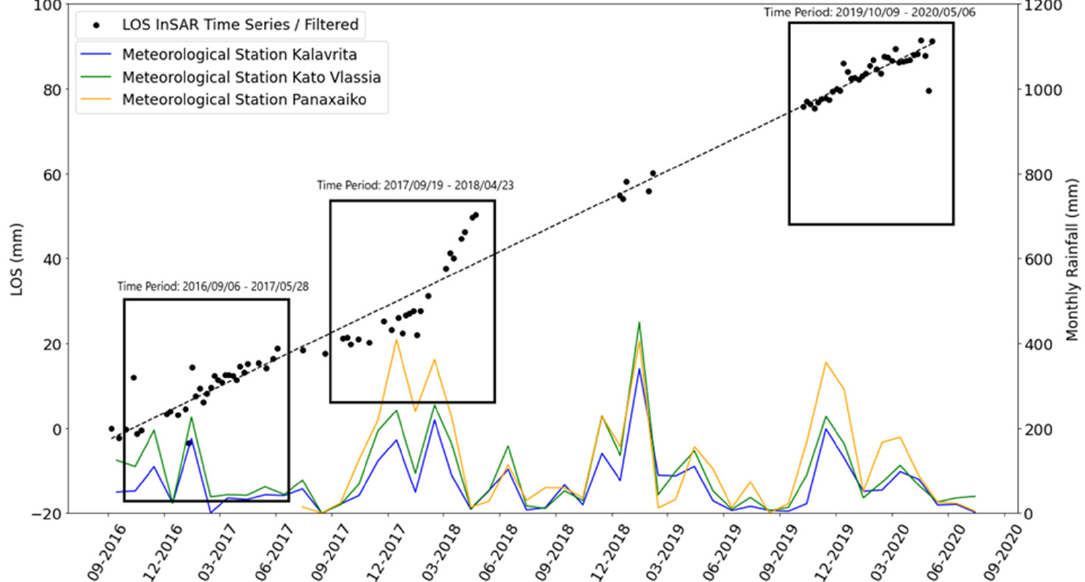
Figure 10 . Graph showing LOS position time series for the Krini landslide descending track (080D). Blue, green and orange lines represent the average monthly rainfall of the meteorological stations Kalavrita, Kato Vlassia and Panachaiko, respectively (right axis). The three black boxes represent the time periods what are used for further processing (see Figure 11). The dashed line indicates the linear fit of the InSAR data for the whole period of observations (25 mm/yr).